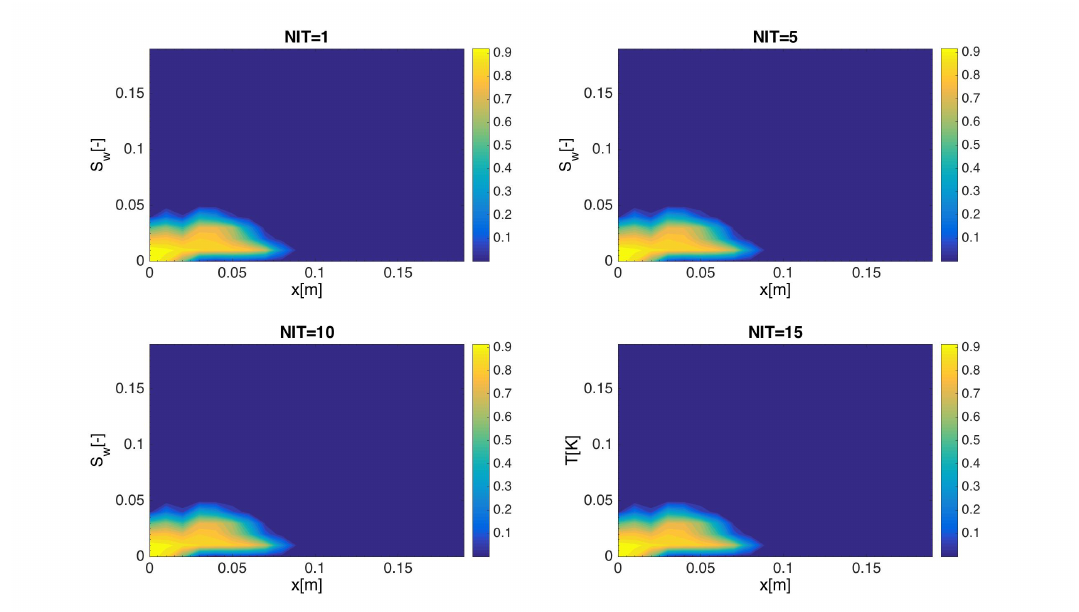
Figure 7. Distribution of saturation on heterogeneous permeability for different number of iterations.